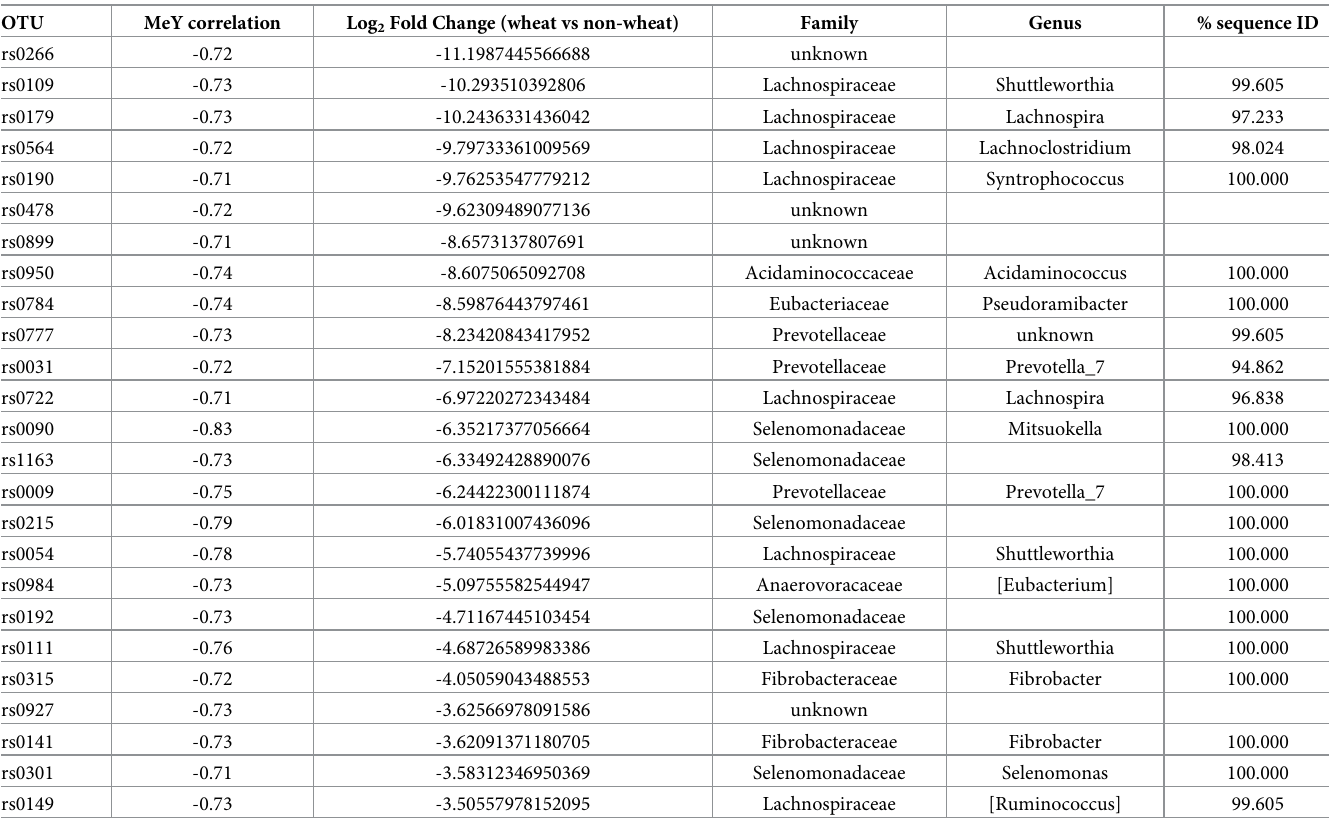
Table 2. Wheat-preferring